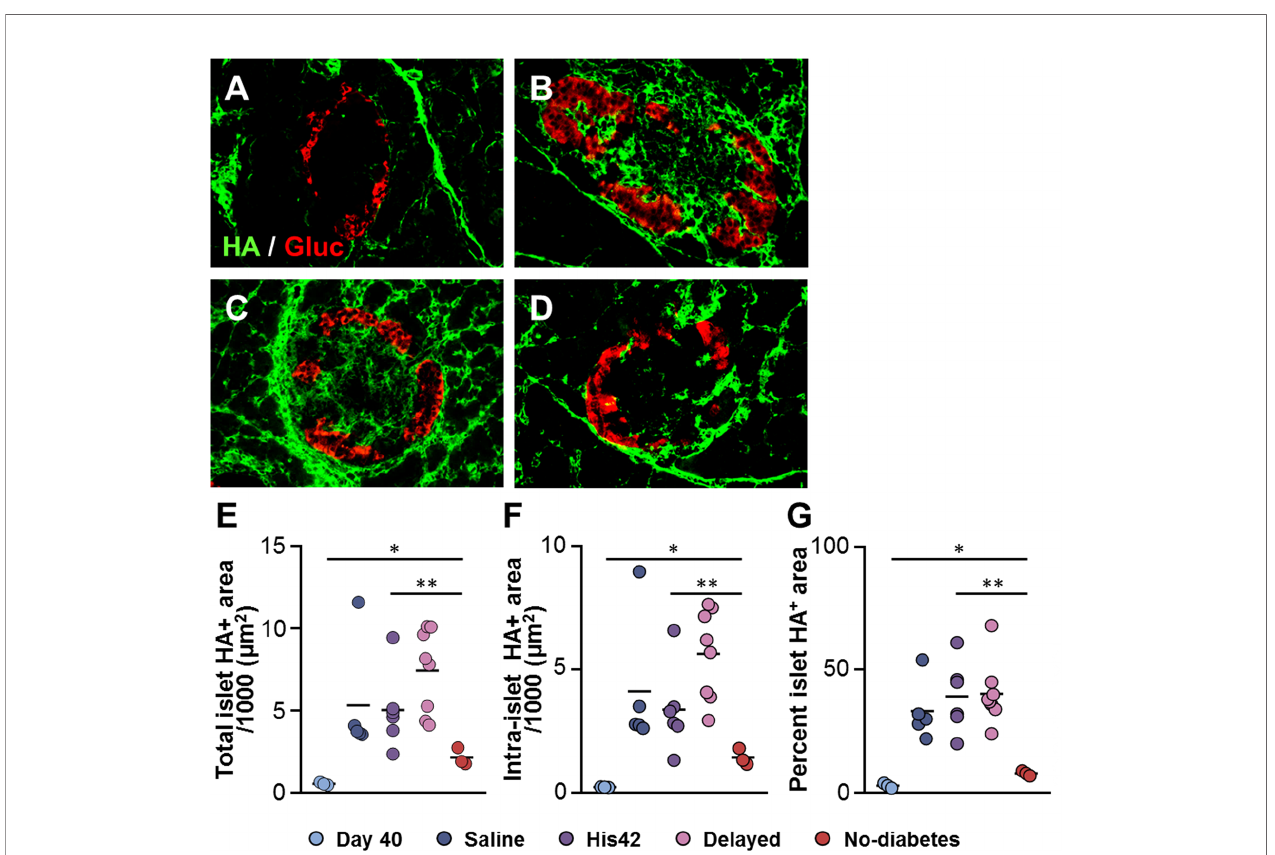
FIGURE 4 | Reduction in islet hyaluronan (HA) in 17D5 no-diabetes DRLyp/Lyp rats. (A – D) HA (green) and glucagon (Gluc, red) staining in islets from DRLyp/Lyp rats at 40 days of age (A) , and from rats in the saline (B) , 17D5 delayed (C) , and 17D5 no-diabetes (D) groups. Scale bar, 50 µm. To avoid redundancy, images from His42-treated rats are not shown. Morphometric quanti fi cation of total (E) and intra- (F) islet HA+ areas. (G) Relative proportion of islet areas stained for HA. Each circle denotes an individual rat; dark slate blue, saline (n = 5); purple, His42 (n = 6); pink, 17D5 delayed (n = 8); red, 17D5 no-diabetes (n = 3); light slate blue, 40 day old (n = 3). Data are mean values measurements obtained for each rat. The solid horizontal lines indicate the mean of the measurements in each group. * P < 0.05, 17D5 no-diabetes vs day 40; ** P < 0.01, 17D5 no-diabetes vs saline, His42, or 17D5 delayed; Mann-Whitney U